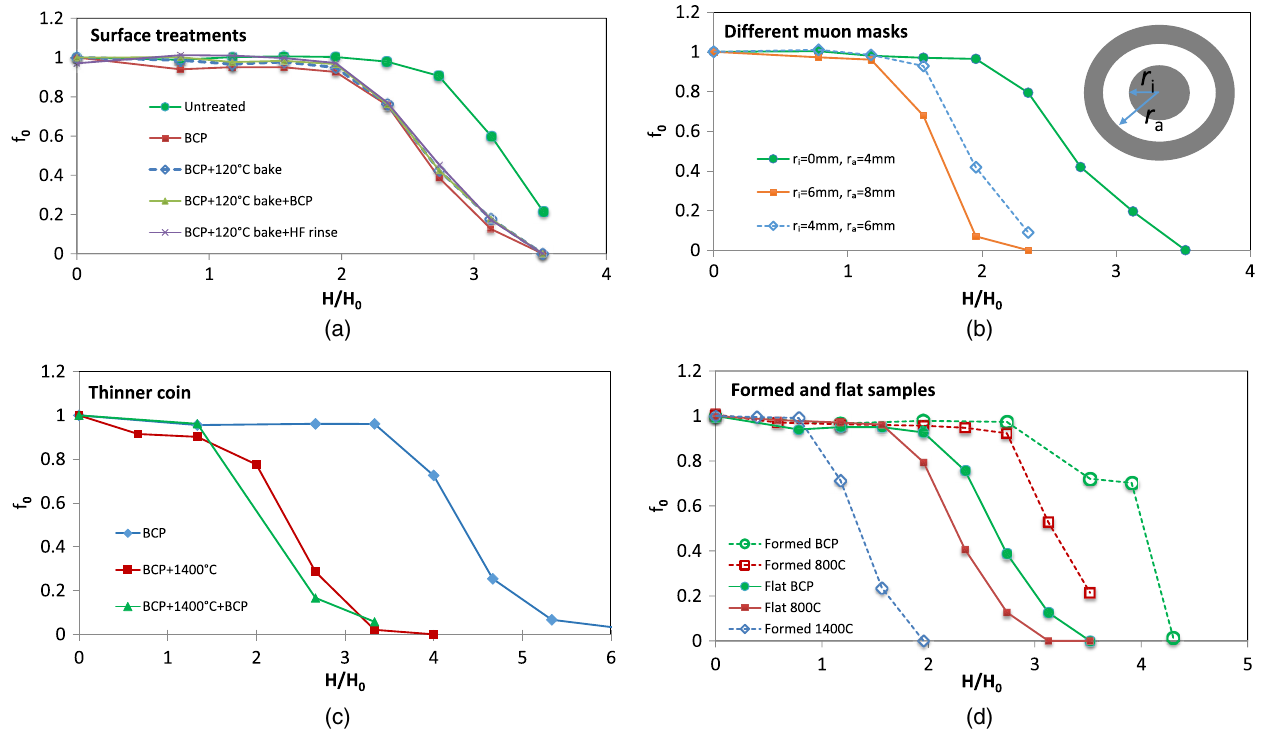
FIG. 12. Fit parameter f 0 signifying the volume fraction probed by the muons which is in the field free Meissner state as a function of applied field for coins in transverse geometry (LAMPF) at 2.5 K. (a) BCP removes the outer damaged layer and releases pinning. Additional surface treatments show no effect on the pinning strength. (b) Different masks, probing different areas on the sample visualize how flux breaks in from the corner of the sample in the transverse coin geometry. (c) A smaller coin of 0.8 mm thickness and 18 mm diameter. The sample was first etched (BCP), followed by annealing ( 1400 °C) and another BCP. The BCP treatment after annealing does not alter the pinning strength. (d) Formed and flat geometries. Formed samples are denoted with dashed lines. This plot shows that forming increases the pinning strength, which is virtually eliminated by a subsequent annealing at 1400 °C.